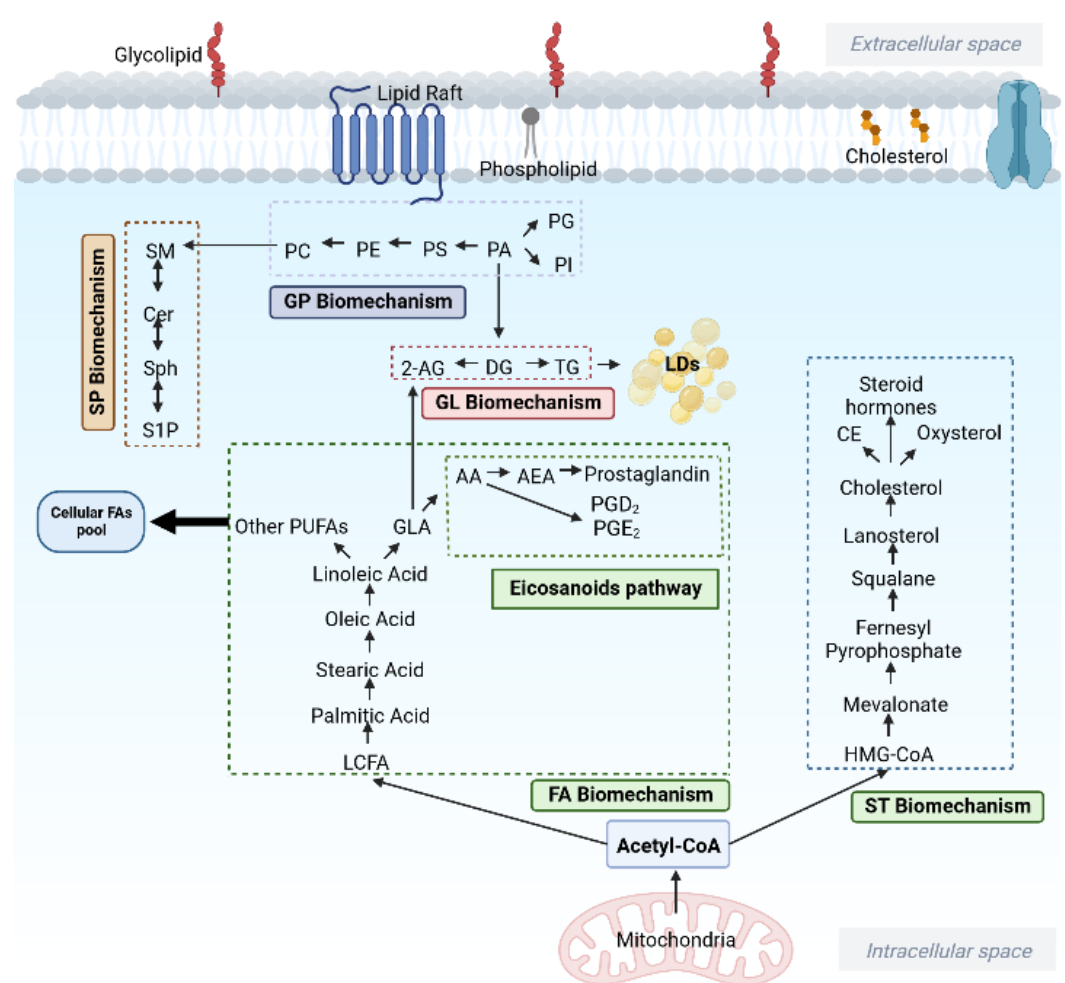
Figure 5. An overview of cellular lipid mechanism, involving lipid biosynthesis from different lipid classes. Adapted from “Phospholipid Bilayer Membrane”, by BioRender.com (2022). Retrieved from https://app.biorender.com/biorender-templates (accessed on 9 November 2022). AA arachidonic acid; AEA anandamide; CE cholesterol ester; Cer ceramide; DG diacylglycerol; FA fatty acyl; GL glycerolipid; GP glycerophosphate; GLA gamma linolenic acid; HMG-CoA 3-hydroxy-3-methylglutaryl coenzyme A; LCFA long-chain fatty acyl; LDs lipid droplets; PA phosphatidic acid; PC phosphatidylcholine; PE phosphatidylethanolamine; PG phosphatidyl-glycerol; PGD2 prostaglandin D2; PGE2 prostaglandin E2; PI phosphatidylinositol; PS phospha-tidylserine; PUFAs polyunsaturated fatty acyls; S1P sphingosine-1-phosphate; SM sphingomye-lin; SP sphingolipid; Sph sphingosine; ST sterol lipid; TG triacylglycerol; 2-AG 2-arachidonoylglycerol.